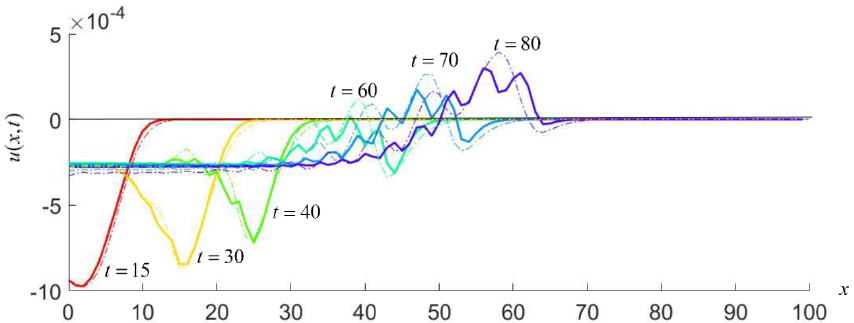
Figure 8. Displacement u(x,t) at different time moments versus the horizontal coordinate x for the tension–compression harmonic impulse: numerical solutions for the discrete chain (solid line), and the bimodular rod (dash-dot line).